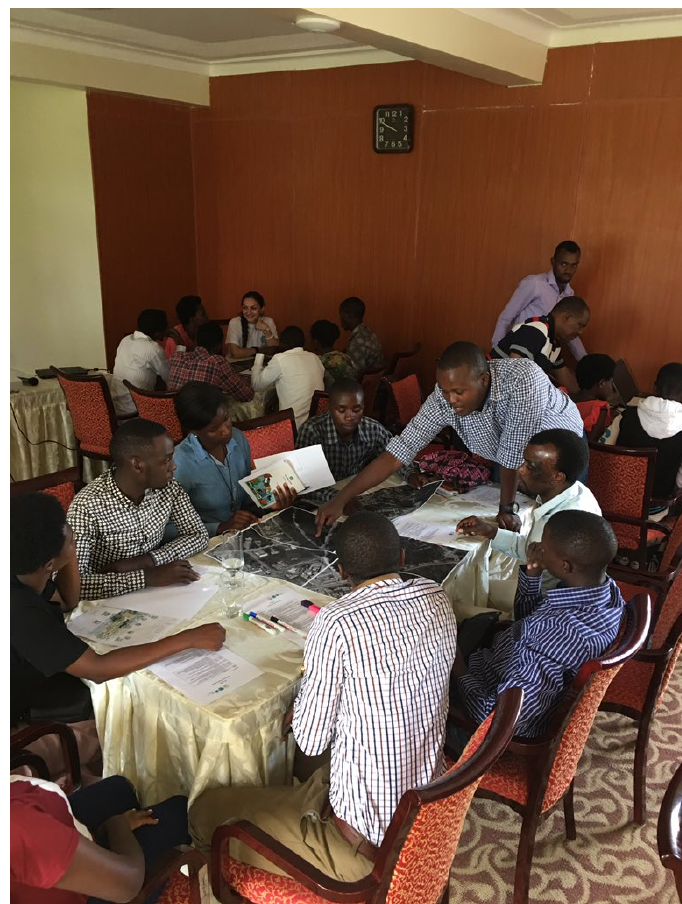
Figure 6. Public space participatory design workshop in Nyagatare, in November 2018. Urban Planning, 2019, Volume 4, Issue 2, Pages